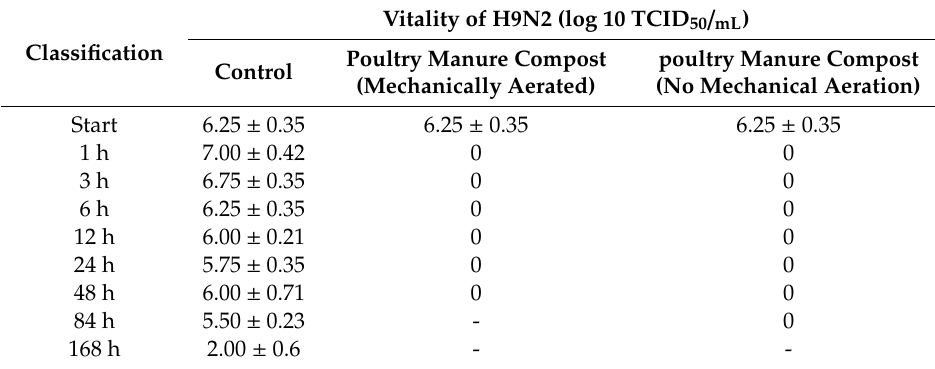
Table 3. Change of vitality of H9N2 with time during composting of poultry manure.